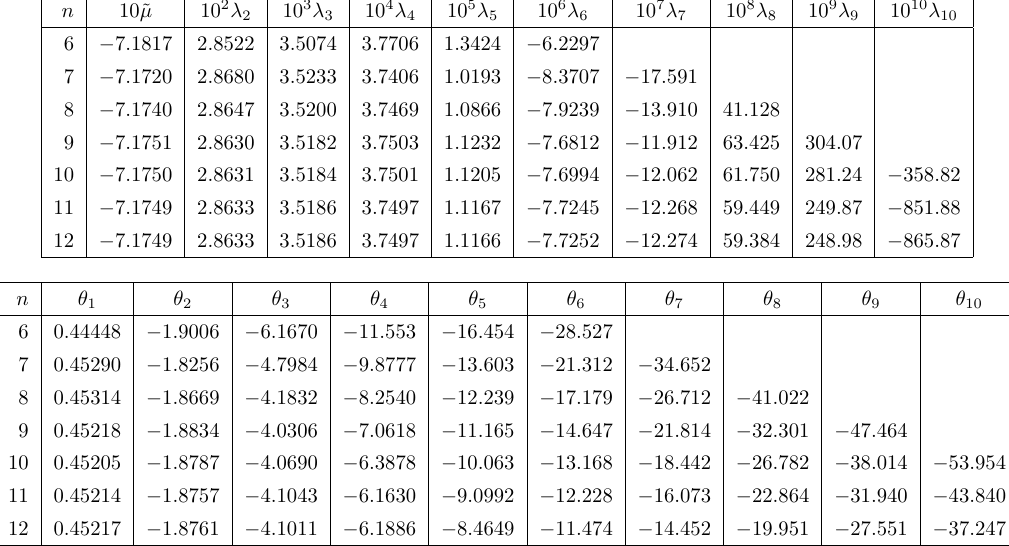
to the GFP. The main difference is that, in the O ( N ) model case, fixed point solutions have additional second pole at negative dimension. These poles correspond to the ¯ µ